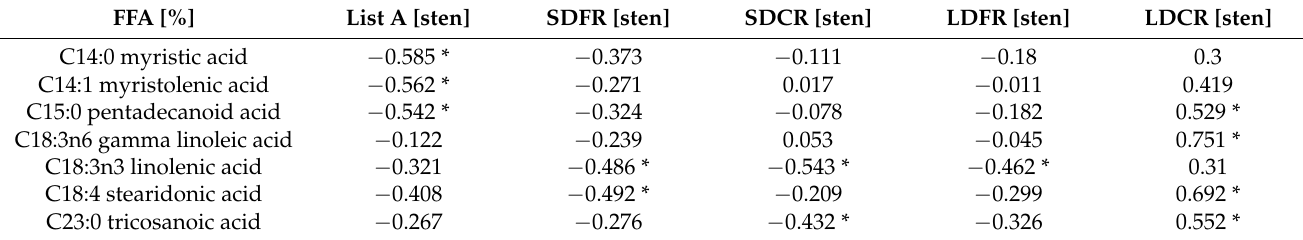
Table 3. The correlations between FFAs and CVLT score obtained 6 months after stroke (CVLT